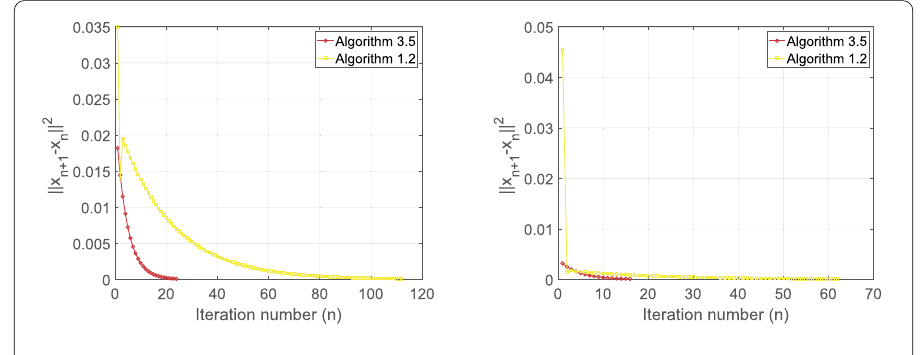
Figure 2 Example 4.2, left: Case I; right: Case II